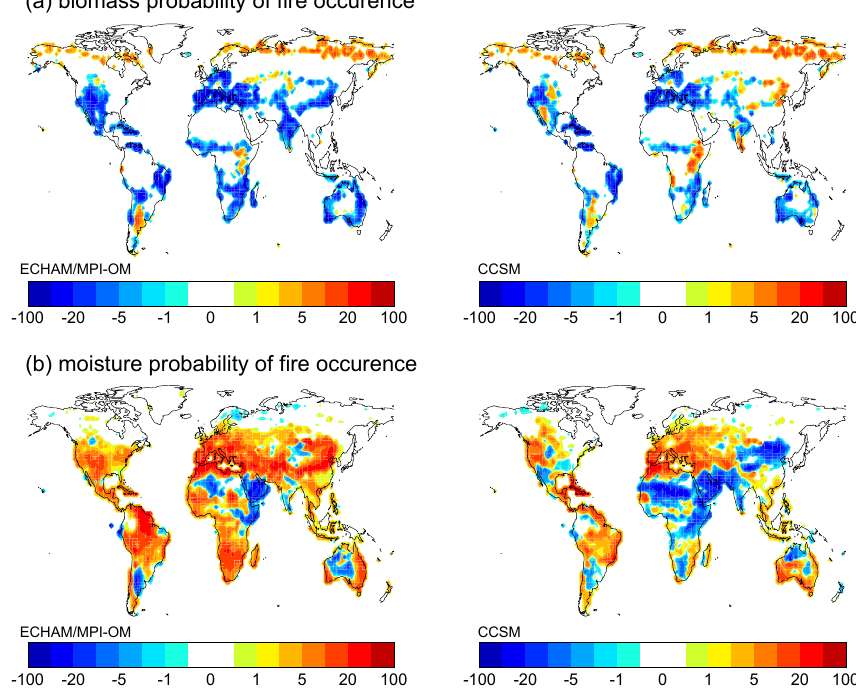
Fig. 6. Change in fire occurence probabilities (annual mean) averaged over the period 2075–2099 compared to the control simulation with constant climate. Left side: ECHAM/MPI-OM (AB-45-E1 minus AB-CLIM-45), right side: CCSM (AB-45-C1 minus AB-CLIM-45). 1st row: biomass probability of fire occurence [ × 100]; 2nd row: moisture probability of fire occurence [ ×